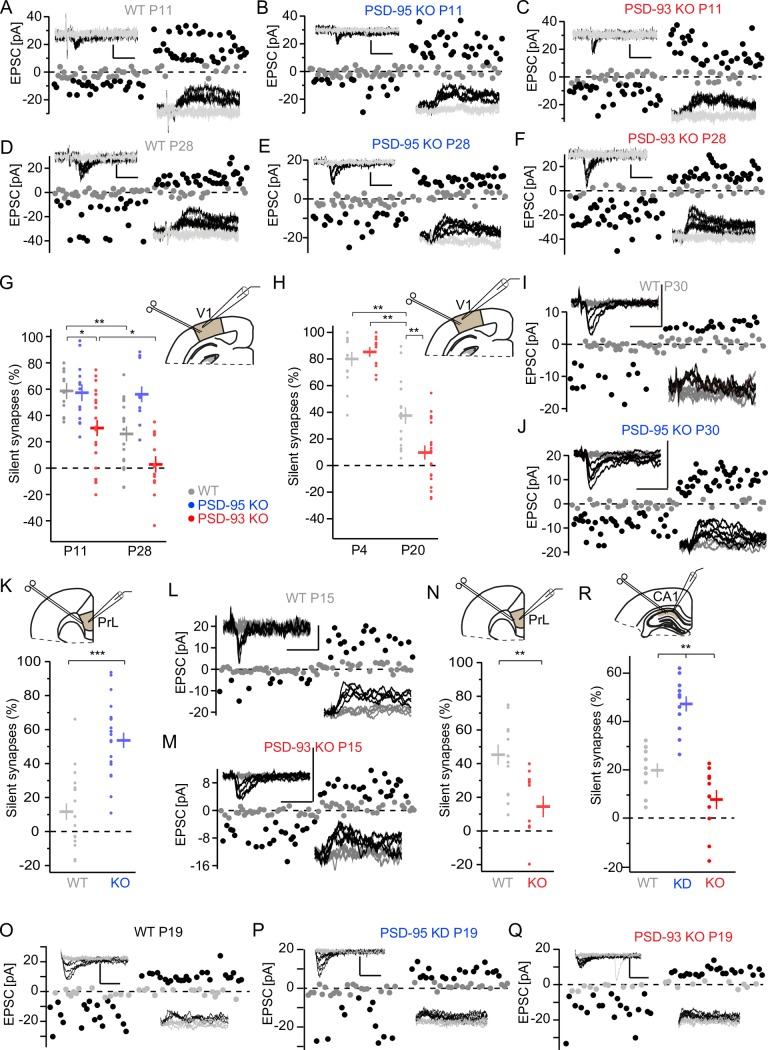
Accelerated developmental decrease of AMPA-silent synapses in the cortex of PSD-93 KO mice.(A–F, I, J, L, M, O–Q) Sample traces of pyramidal neuron EPSCs from different brain areas using minimal stimulation of afferents of mice with different genotypes and ages. Sample traces (insets) and analysis of the peak values of AMPA receptor EPSCs, recorded at Vh = −60 mV (downward deflection), or composite glutamate receptor EPSCs, recorded at Vh = +40 mV (upward deflection), of successes (black) and failures (gray) of individual EPSCs are depicted. Scale bar: 20 ms and 25 pA. (A-F) Sample traces from V1 layer 2/3 pyramidal neurons with L4 afferents of P11/P28 WT (A/D), PSD-95 KO (B/E), and PSD-93 KO (C/F) mice. (G-H) Summary graphs of the fraction of silent synapses of WT (gray), PSD-95 KO (blue), and PSD-93 (red) mice at different developmental time points. Dots represent values of single neurons; horizontal bars are genotype averages. Recording scheme of layer 2/3 pyramidal neuron of V1 in coronal brain slices is depicted in inset, with patch pipette and bipolar stimulating electrode. *p < 0.05, **p < 0.01. See also S1 Fig. Underlying data for this figure can be found in S1 Data. (I, J, L, M) Sample traces of mPFC layer 2/3 pyramidal neuron with white matter afferents of P30/P15 WT (I/L), P30 PSD-95 KO (J), and P15 PSD-93 KO (M). (K, N) Summary graphs of the fraction of silent synapses of WT (gray), PSD-95 KO (blue), and PSD-93 KO (red) mice at different developmental time points. Recording scheme of layer 2/3 pyramidal neuron of the mPFC PrL in coronal brain slices is depicted in inset, with patch pipette and bipolar stimulating electrode. **p < 0.01, ***p < 0.001. Underlying data for this figure can be found in S1 Data. (O-Q) Sample traces of hippocampal CA1 pyramidal neuron with Schaffer collateral afferents of P20 WT (O), PSD-95 KD (P), and PSD-93 KO (Q). (R) Summary graphs of the fraction of silent synapses of WT (gray), PSD-95 KD (blue), and PSD-93 KO (red) mice at P20. Recording scheme of CA1 pyramidal neuron of V1 in coronal brain slices is depicted in inset, with patch pipette and bipolar stimulating electrode. **p < 0.01. Underlying data for this figure can be found in S1 Data. AMPA, α-amino-3-hydroxy-5-methyl-4-isoxazole propionic acid; CA1, Cornu Ammonis 1; EPSC, excitatory postsynaptic current; KD, knock-down; KO, knock-out; L4, layer 4; mPFC, medial prefrontal cortex; P, postnatal day; PrL, prelimbic cortex; PSD, postsynaptic density; Vh, holding potential; V1, primary visual cortex; WT, wild-type.